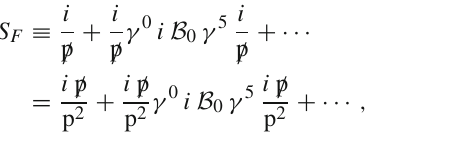
the case of the U(1) chiral anomaly